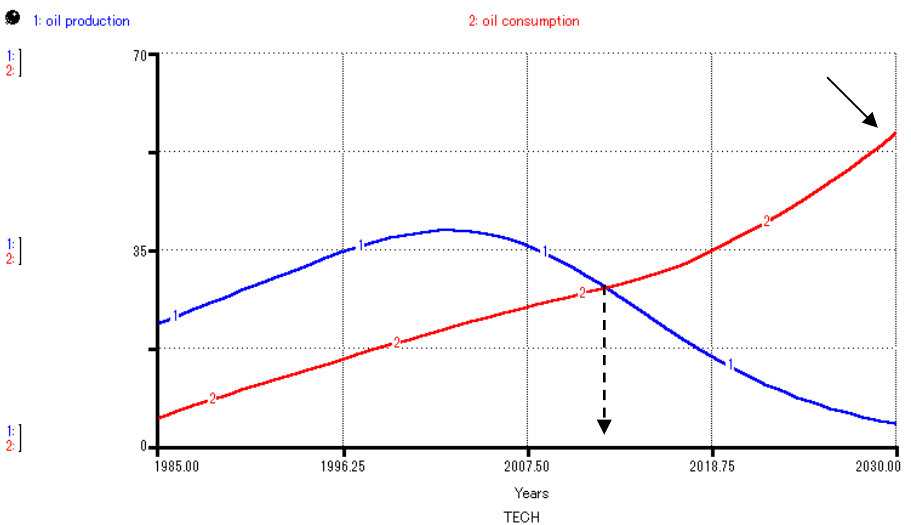
Figure 19. Oil production and consumption in the TECH